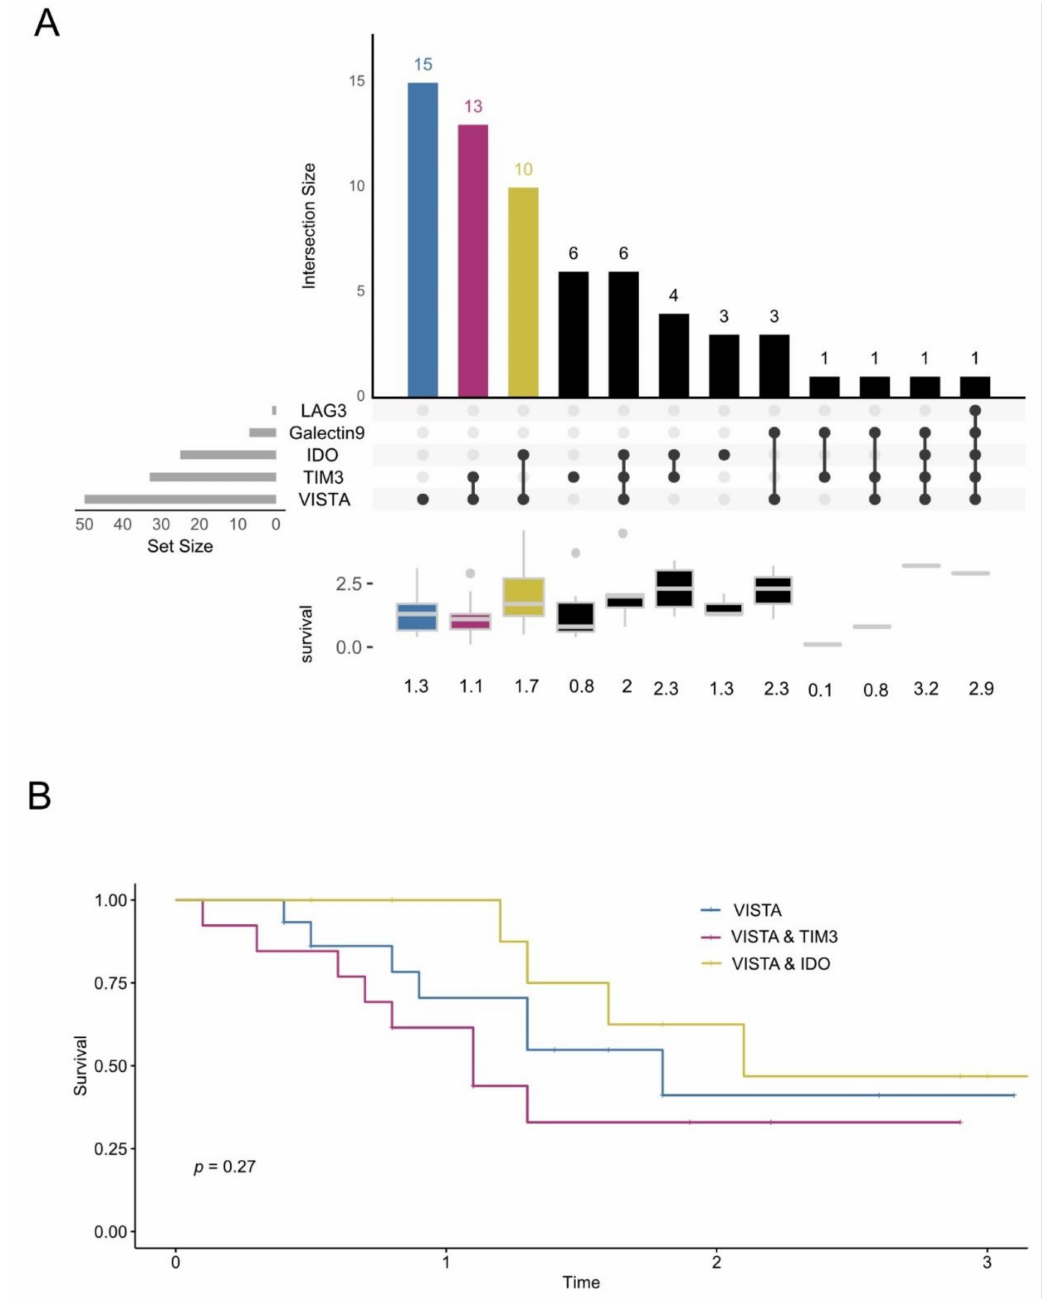
Figure 4. UpSet plot to visualize the intersecting sets of immune molecule expression. ( A ) VISTA was the most frequently expressed immune molecule (44% of all tumors, n = 113), Fifteen tumors expressed VISTA alone (13%) and no other immune molecules, followed by thirteen tumors expressing VISTA and TIM3 only (12%), and ten tumors expressing VISTA and IDO (9%). The box plot below depicts the median survival of the immune molecule combinations depicted in the UpSet plot above. ( B ) Survival of the patients with VISTA-, VISTA- and TIM3-, and VISTA- and IDO-expressing tumors ( n = 38, p = 0.27, log-rank